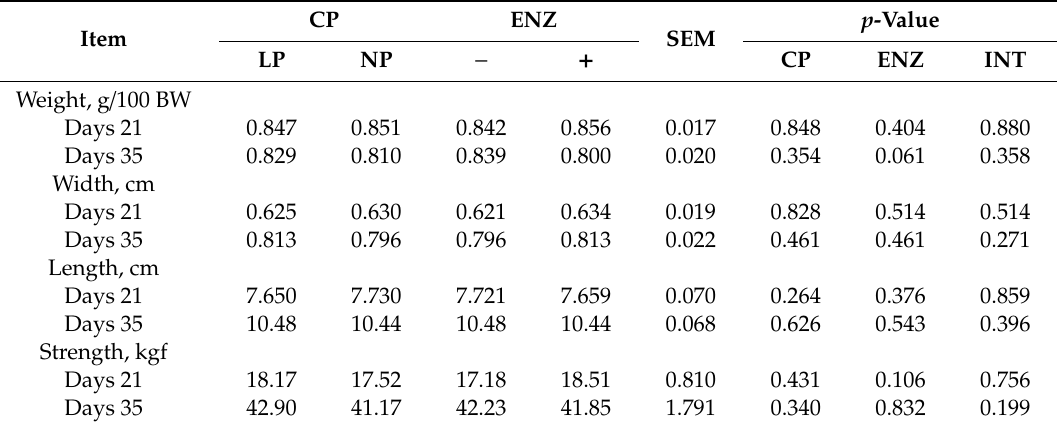
CP = crude protein; NP = Normal protein diet; LP = low-protein diet; ENZ = protease; INT = interaction; BW =